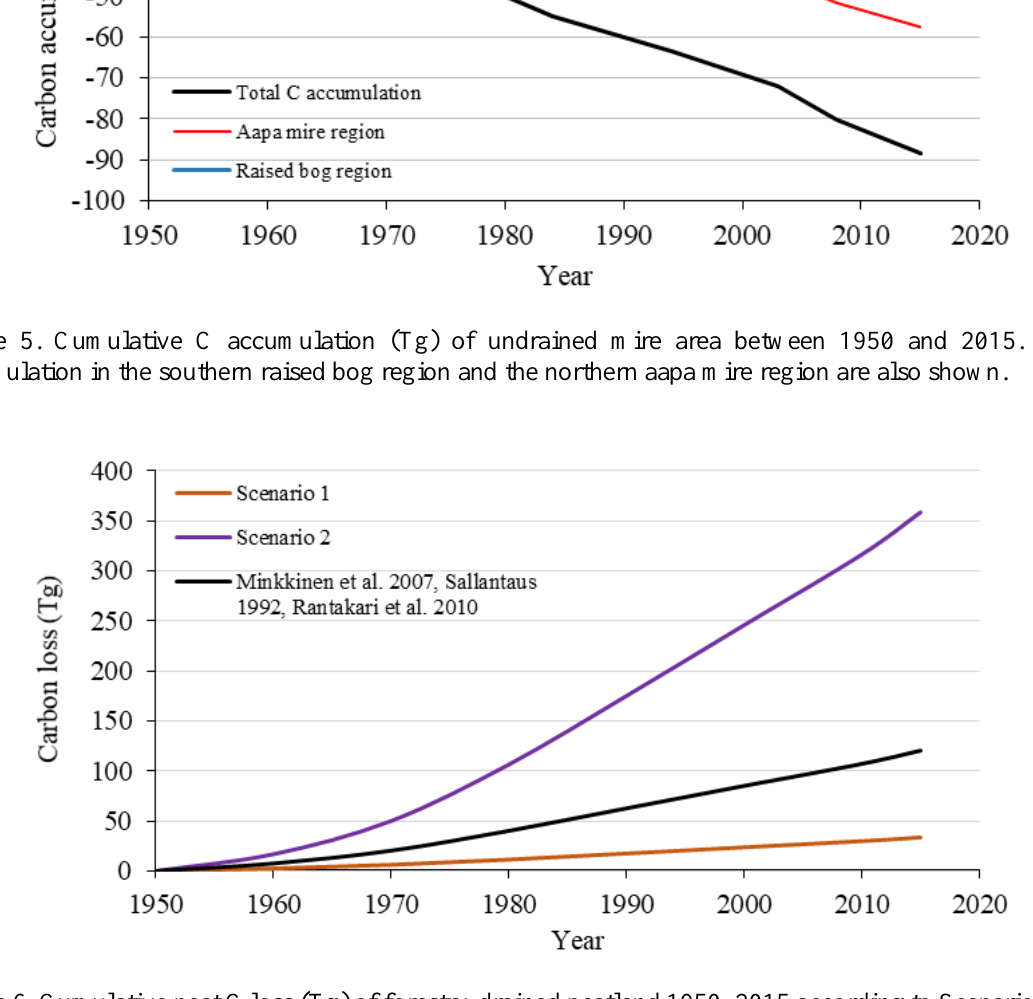
Figure 6. Cumulative peat C loss (Tg) of forestry-drained peatland 1950–2015 according to Scenarios 1 and 2. A cumulative C loss based on combined CO 2 estimates of Minkkinen et al. (2007) and DOC estimates of Sallantaus (1992) and Rantakari et al. (2010) are shown for